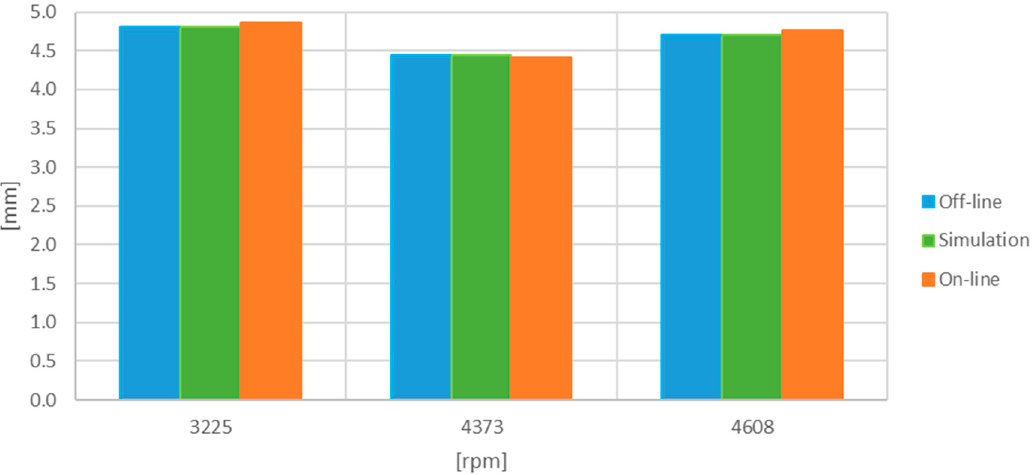
Figure 12. Minimum TC [mm] obtained with the one-turn-filtered set of signals.